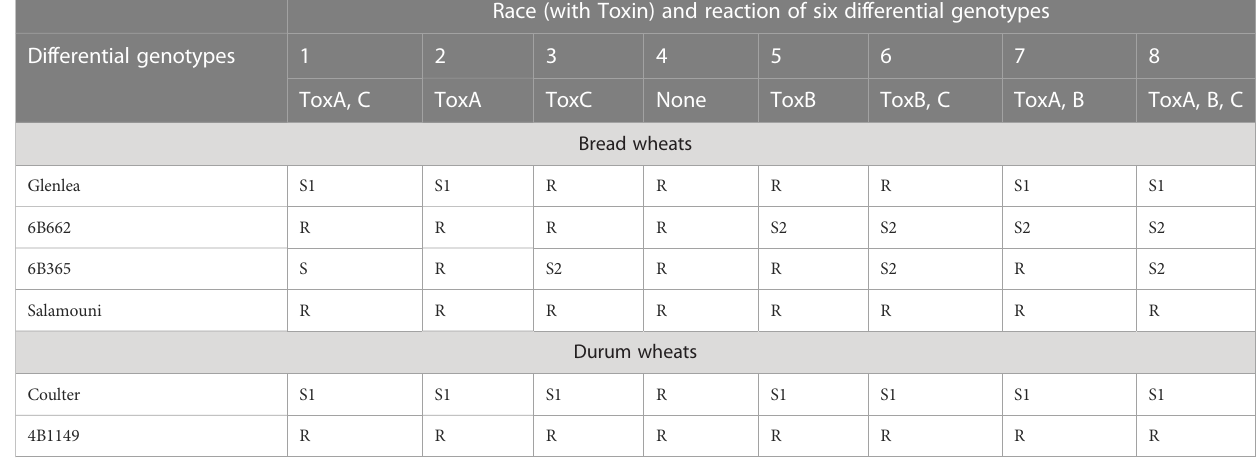
TABLE 5 Reaction of eight races of P. tritici-repentis on four bread and two durum wheat differential lines. Race (with Toxin) and reaction of six differential genotypes Differential